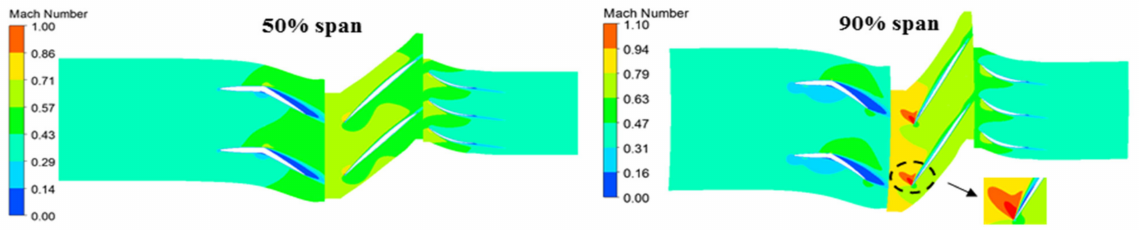
Figure 10. Mach number distribution of the operating point.